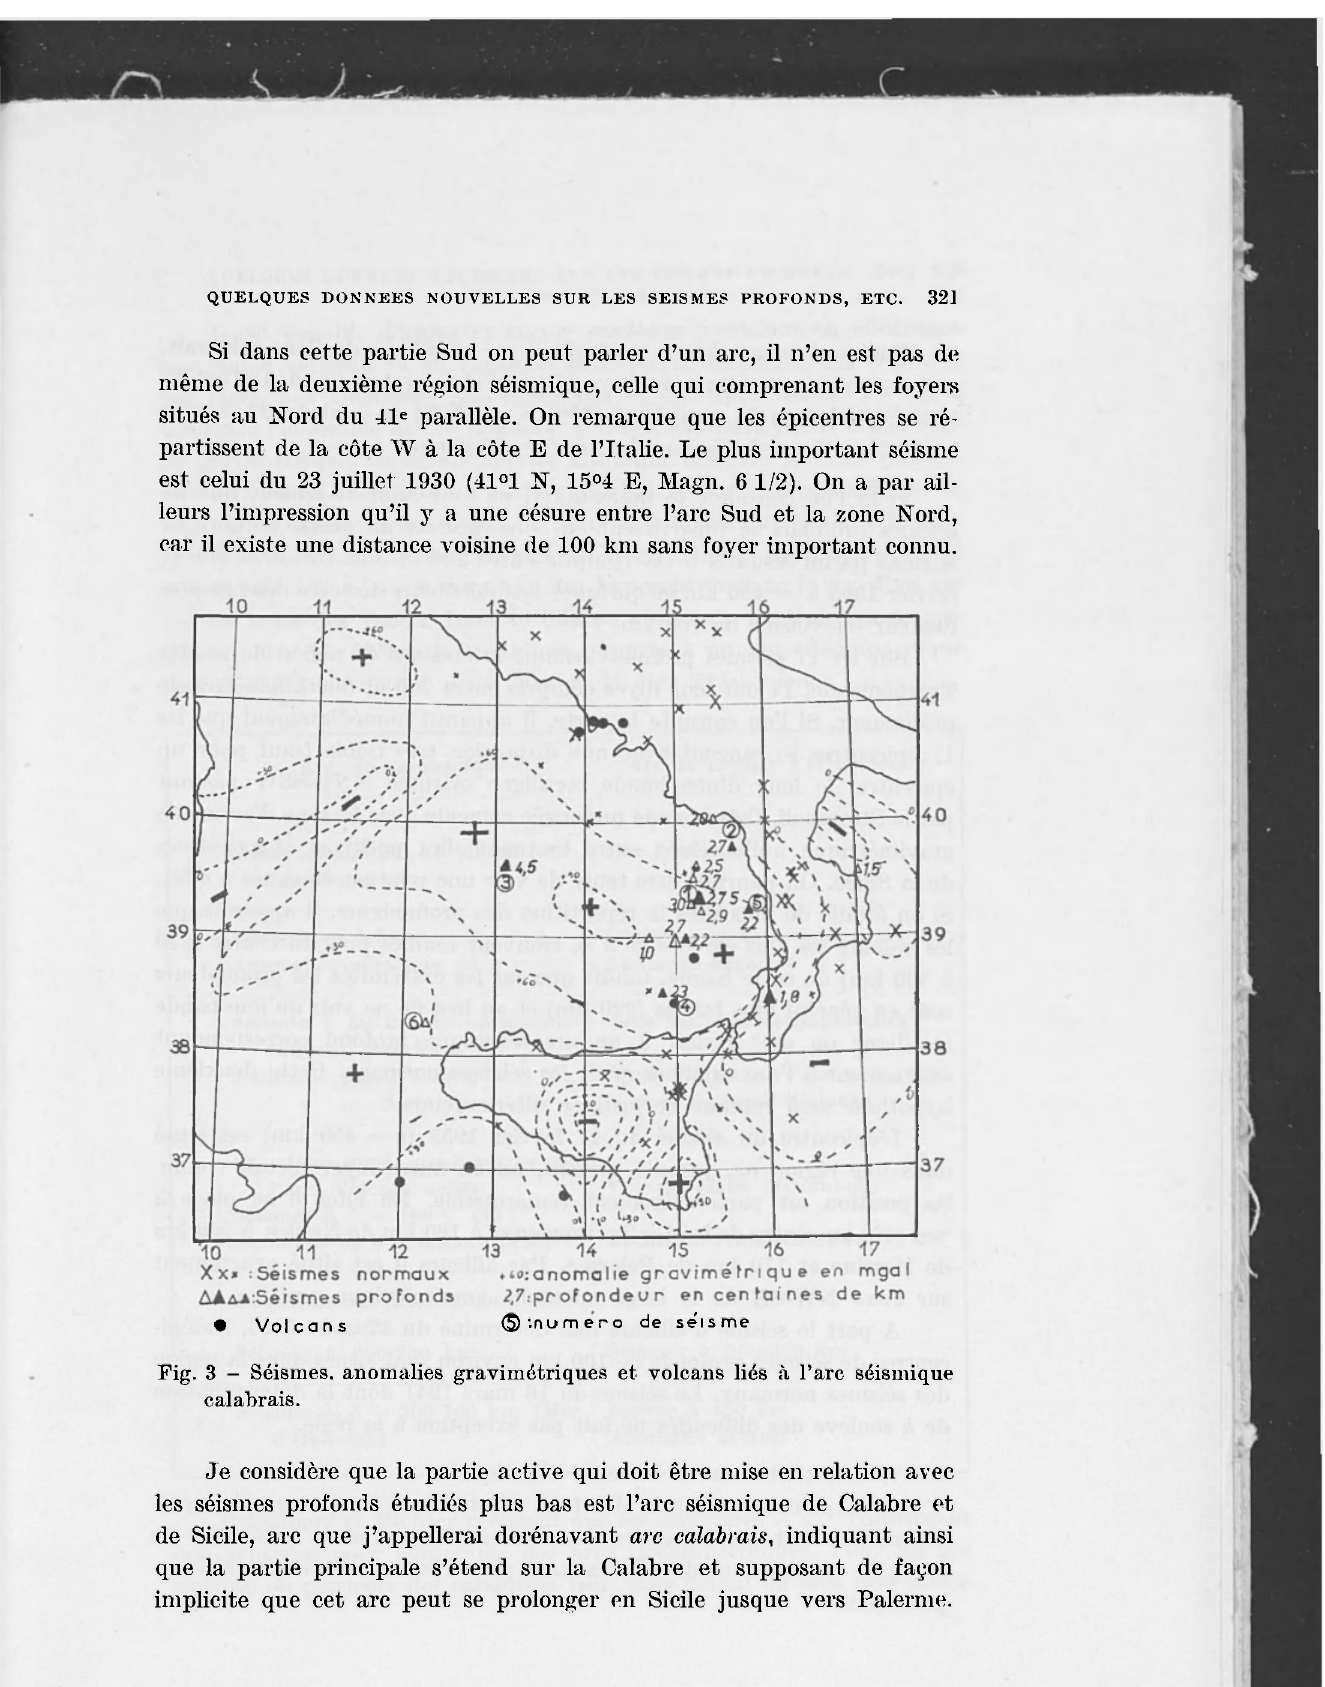
Fig. 3 - Séismes. anomalies gravimótriques et volcans liés à l'are séismique